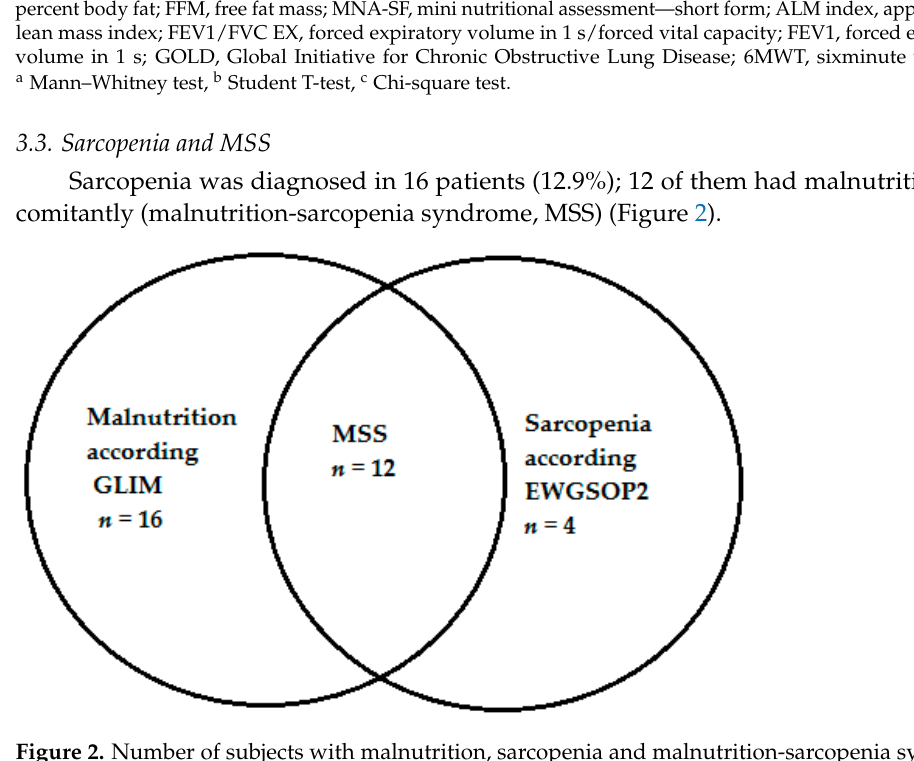
Figure 2. Number of subjects with malnutrition, sarcopenia and malnutrition-sarcopenia syndrome. Notes: GLIM, Global Leadership Initiative on Malnutrition; MSS, malnutrition-sarcopenia syn- dromeEWGSOP2, European Working Group on Sarcopenia in Older People 2.